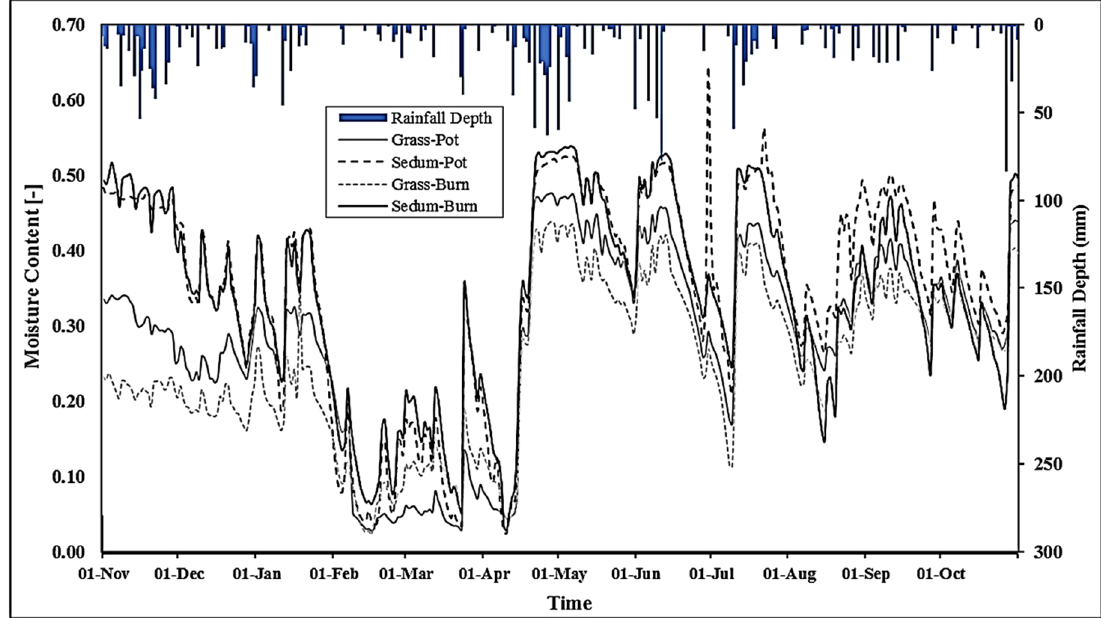
Figure 2. Daily rainfall and substrate moisture profiles at each test bed during the monitoring period from 1 November 2015 to 31 October 2016.